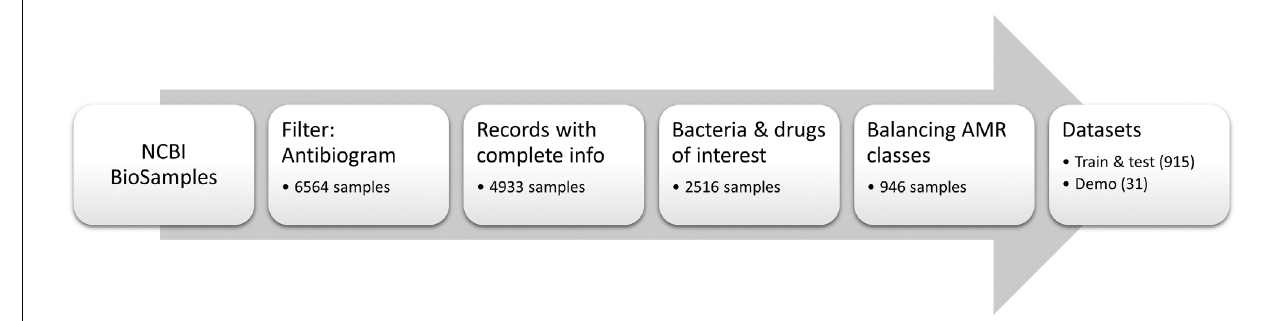
FIGURE 1 | Data collection of public samples from NCBI. The numbers of samples represent total samples remaining in the dataset after a given data processing step.